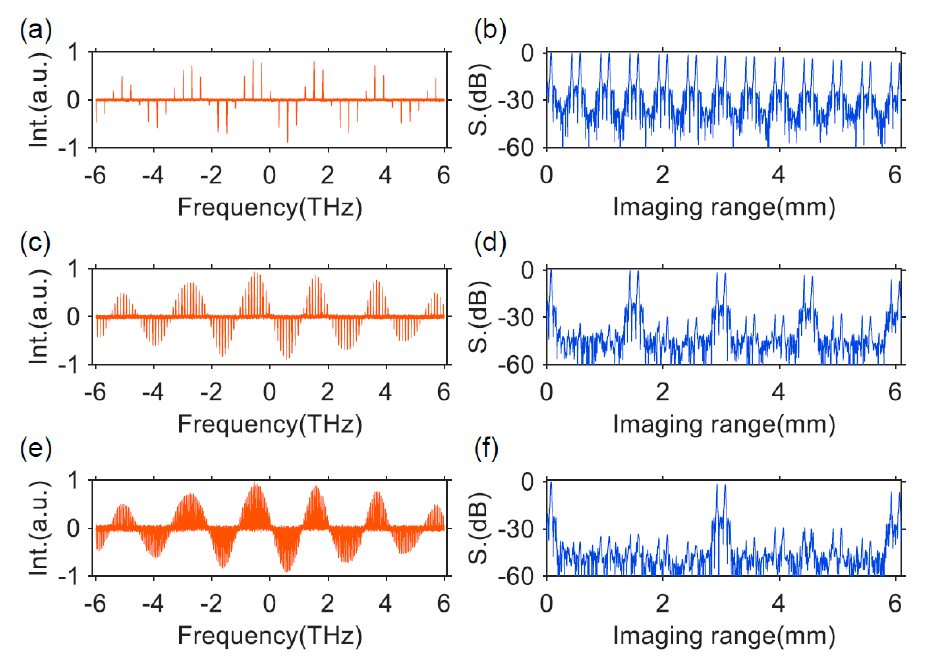
Figure 15. ( a , c , e ) show the resampled interference fringes in the frequency domain and ( b , d , f ) show the calculated point spread functions (PSFs) of discrete FDML laser with 300, 100 and 50 GHz FSR. Reprinted with permission from Ref. [95].